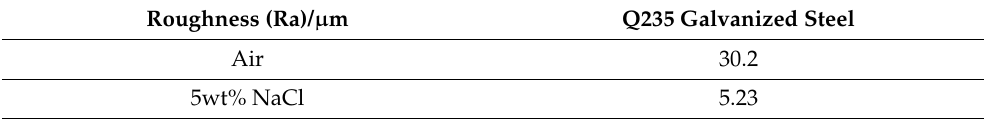
Table 6. Fatigue fracture roughness of Q235 galvanized steel in air and 5wt% NaCl. Roughness (Ra)/μm